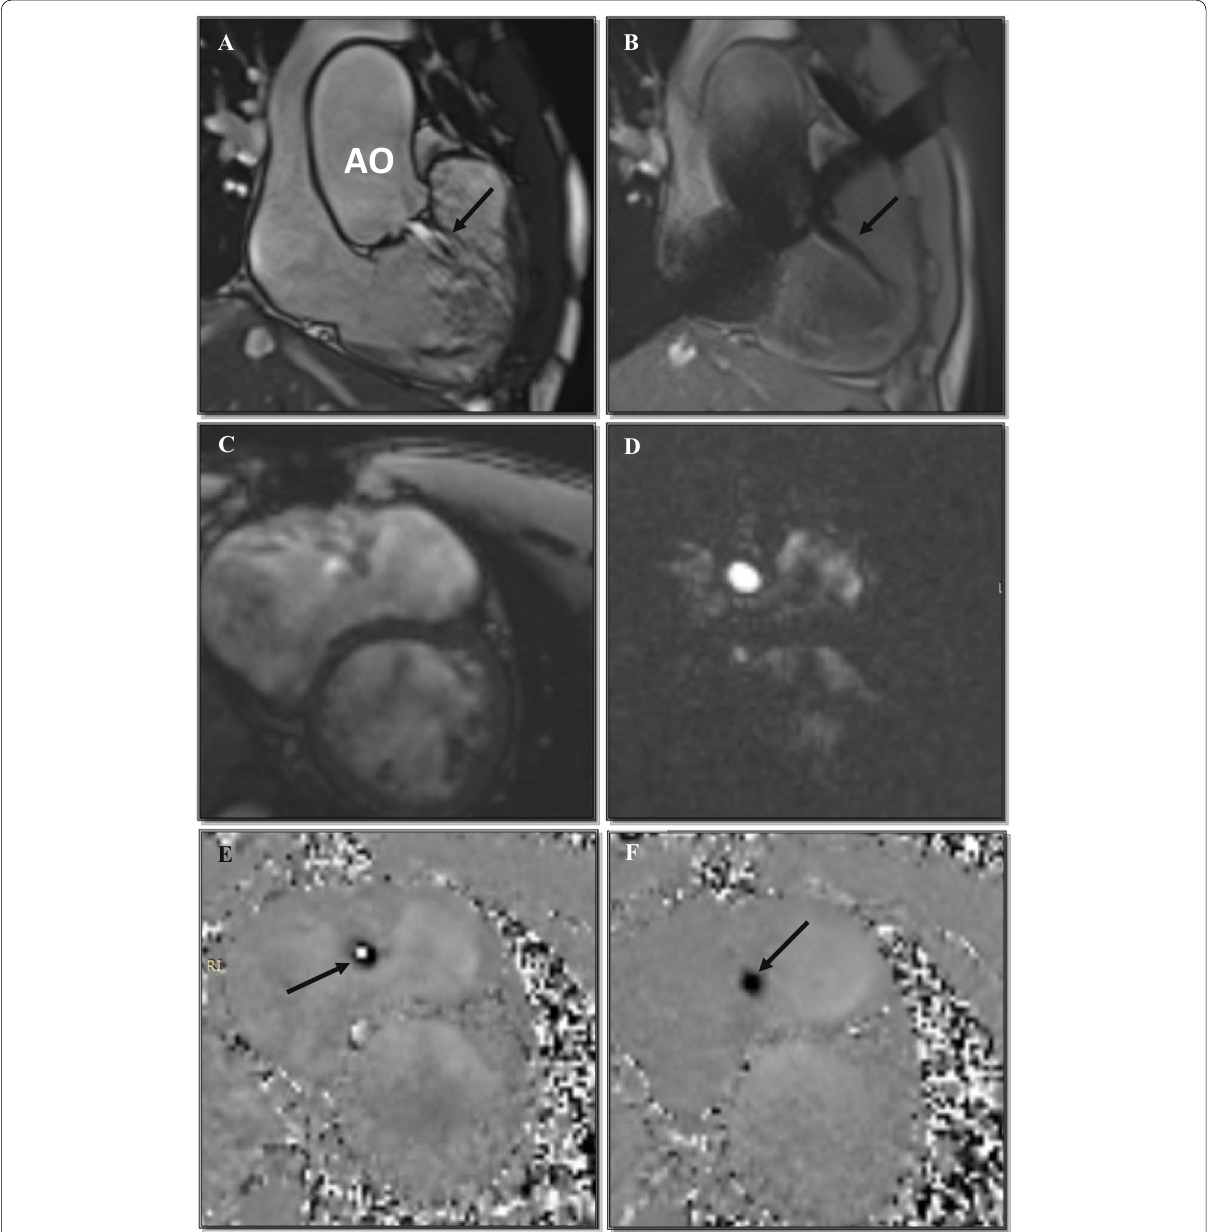
Fig. 4 A – L CMR revealed: Dilated RV, aortic regurgitation, RF 5% with dilated aortic root and Asc.Ao, moderate PR, RF 40%, residual PS, = = maximum velocity 2.5 m/s, residual VSD (flow across 59 ml, maximum velocity reached 4.5 m/s) (estimated gradient about 81 mmHg) and Qp/ = Qs 1.4:1. A 30-year-old male patient, diagnosed as tetralogy of Fallot, underwent RVOT repair at age of 4-year-old. The patient was referred for CMR study for follow-up (RV volumes, function and Qp/Qs quantification). A , B Right inflow/outflow cine images with and without saturation band showing systolic VSD jet and dilated aortic root. C , D , E Phase-contrast velocity encoding sequence for VSD with Venc 2.5 m/s; anatomy, magnitude and phase images showing aliasing across the VSD at this Venc denoting the need for increasing Venc for proper velocity and flow assessment. F Phase-contrast velocity encoding sequence for VSD with Venc 4.5 m/s; phase image showing no aliasing across the VSD denoting optimum velocity. G , H Sagittal pulmonary phase-contrast velocity encoding sequence (in-plane) at Venc 2 m/s; anatomy and phase showing aliasing denoting need for increasing the Venc for proper velocity and flow assessment. I , J Sagittal pulmonary phase-contrast velocity encoding sequence (in-plane) at Venc 2 m/s; two images, anatomy and phase showing pulmonary regurgitation during diastole. K LVOT cine image showing aortic regurgitant jet during diastole as well as dilated aortic root . L Axial localizer image showing dilated ascending aorta measured at the level of pulmonary bifurcation measuring about 5.19 4.9 ×